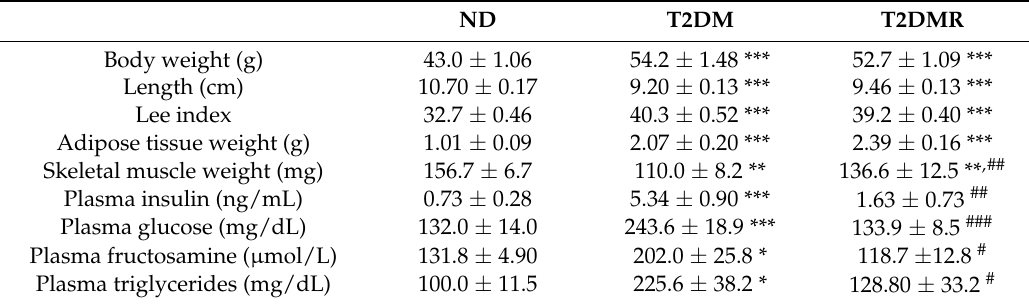
Table 1. Morphometric and metabolic characteristics of the non-diabetic (ND), type 2 diabetic (T2DM), and resveratrol-treated type 2 diabetic (T2DMR) mice.